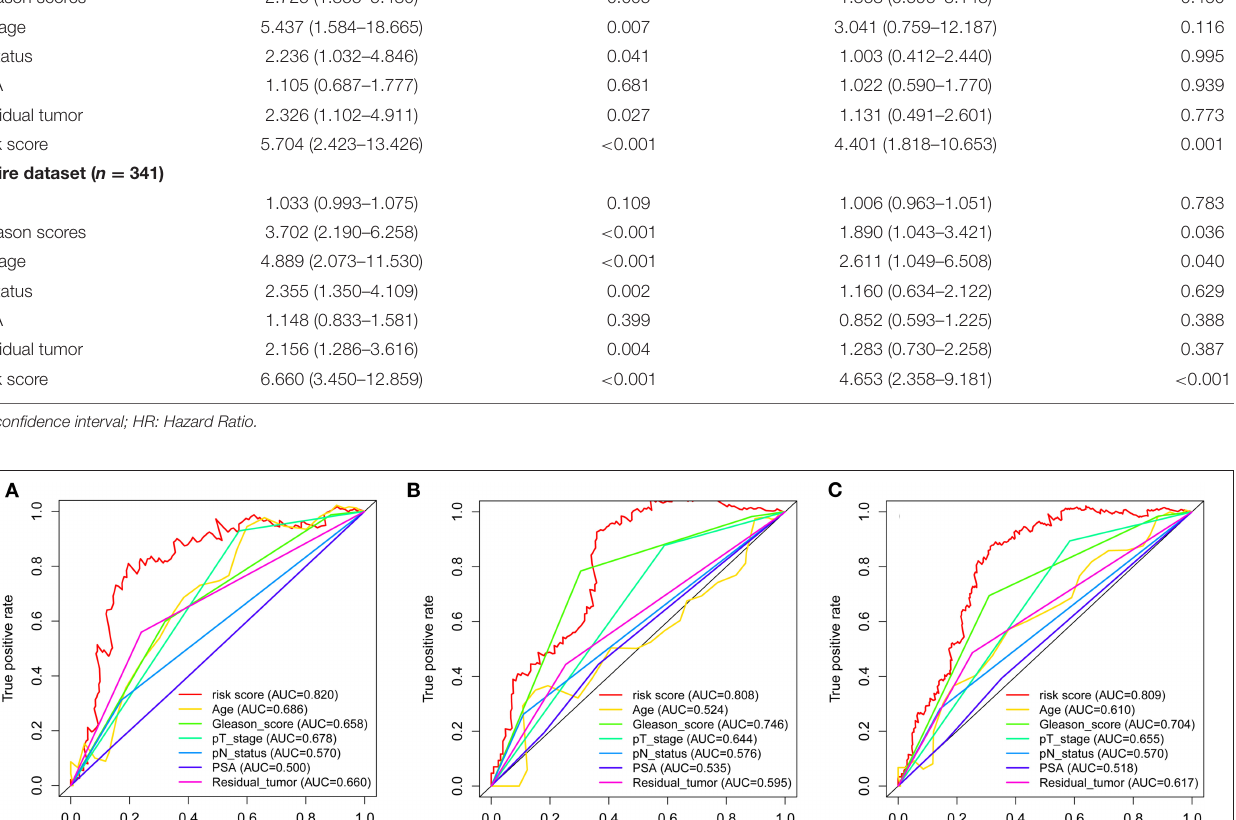
utility, outperforming the known model with an AUC of